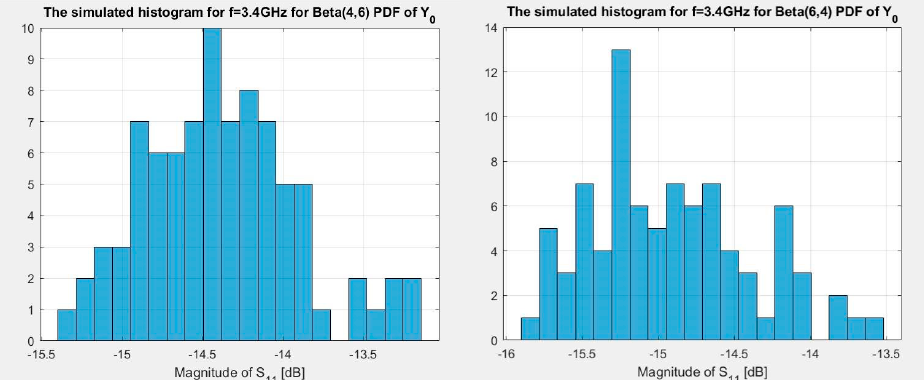
Figure 8. Histogram of | S 11 | obtained from the simulation results for y 0 having Uniform and Beta distribution with the shape parameters α = β = 6 for antenna design from Figure 1.